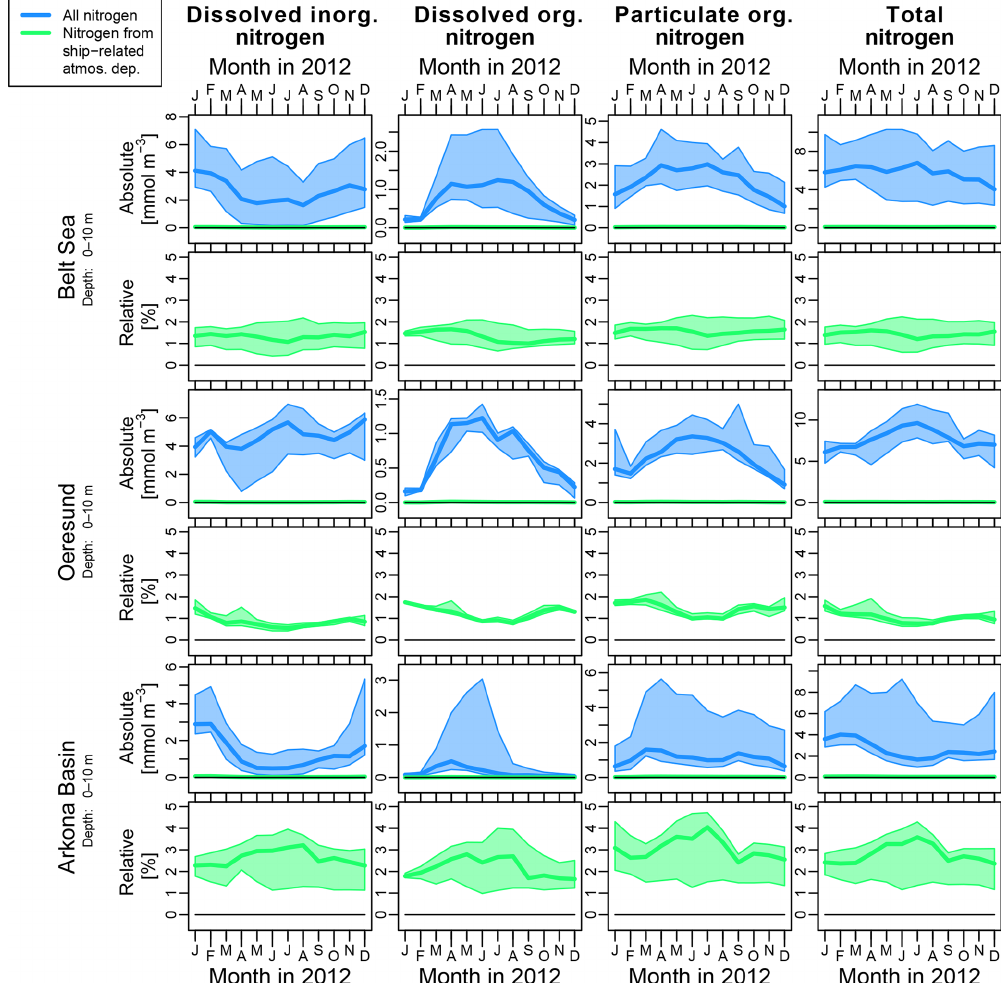
Figure 8. Monthly concentrations of dissolved inorganic nitrogen (DIN), dissolved organic nitrogen (DON), particulate organic nitrogen (PON), and total nitrogen (TN), with all nitrogen (blue; darker color in grayscale) and shipping-related nitrogen (green; lighter color in grayscale) in the odd rows. The ratio between shipping-related and all nitrogen of the same compounds is in the even rows. Each pair of rows represents data for one of the basins: Belt Sea, Öresund, and Arkona Basin (top to bottom). The horizontal median as well as the 10th and 90th percentiles are plotted. The thick lines are the medians and the shaded area covers the interval between the 10th and 90th percentiles. The statistics were calculated from monthly and vertically (top 10m) averaged concentrations. For the ratios, (first) the vertical and temporal averages, (second) the quotients, and (third) the median and percentiles were